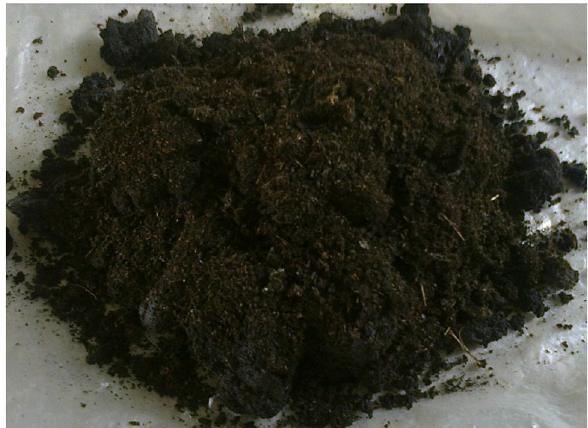
Figure 2. The organic fertilizer produced and used in this study.